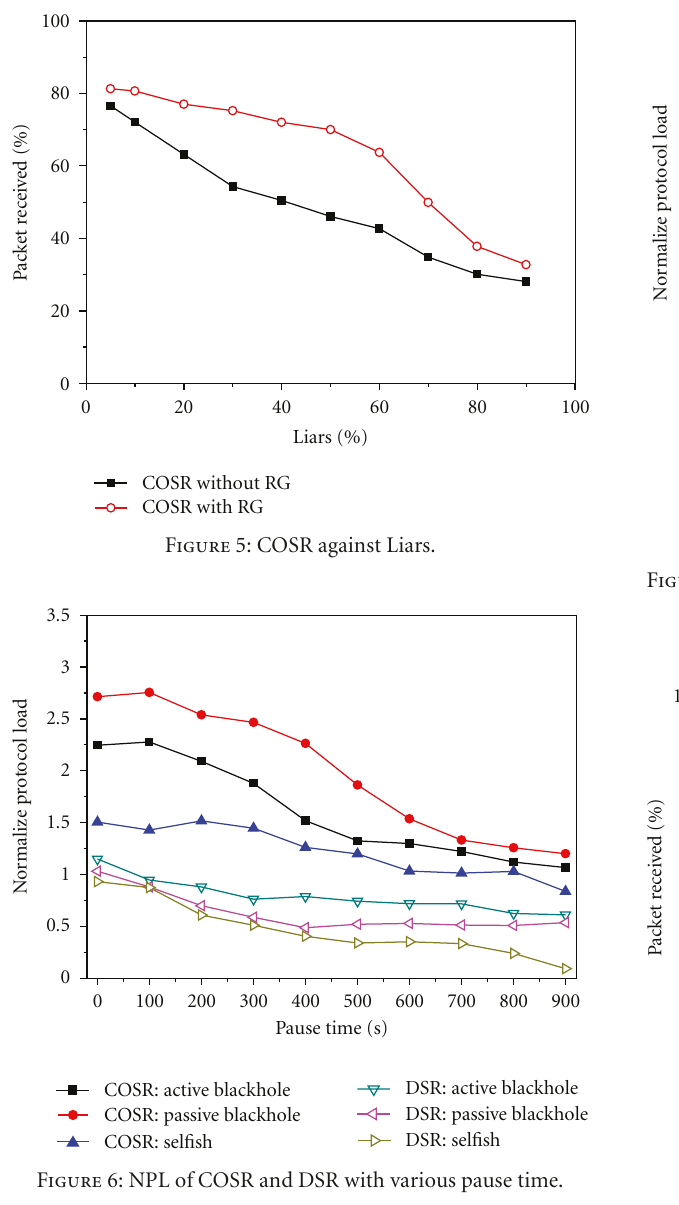
Figure 6: NPL of COSR and DSR with various pause time.